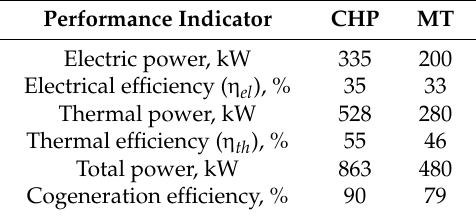
Table 1. Technical data of onside combined heat and power unit (CHP) and micro turbine (MT). Performance Indicator